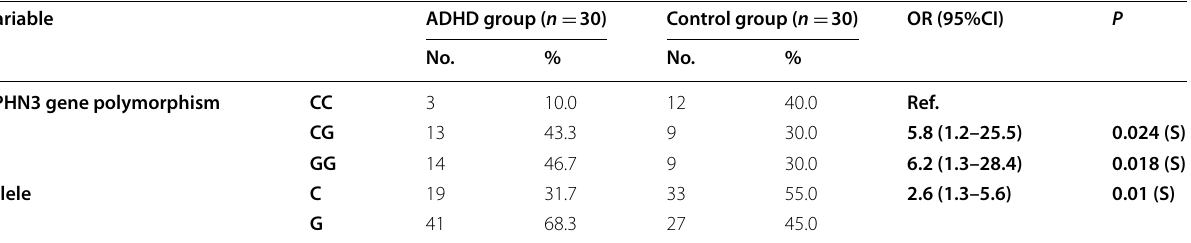
Table 2 Comparing the studied groups regarding gene polymorphism